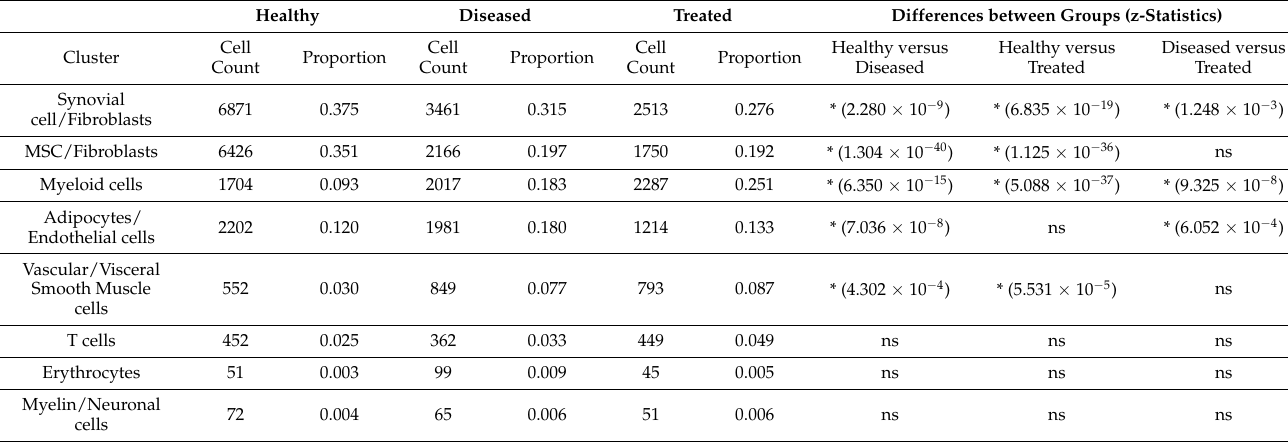
Table 1. Overall cell count and proportion in each defined cluster for each sample group. Healthy Diseased Treated Differences between Groups (z-Statistics)